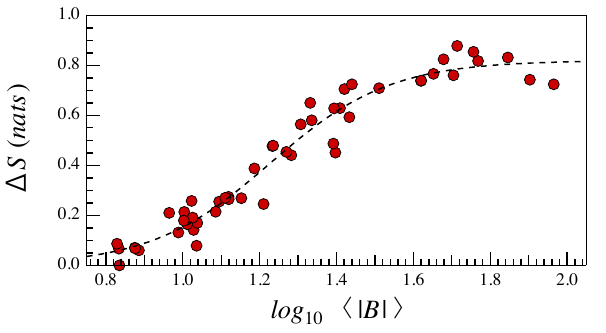
(cid:104)| B |(cid:105) . The dashed curve is a sigmoid fit 10